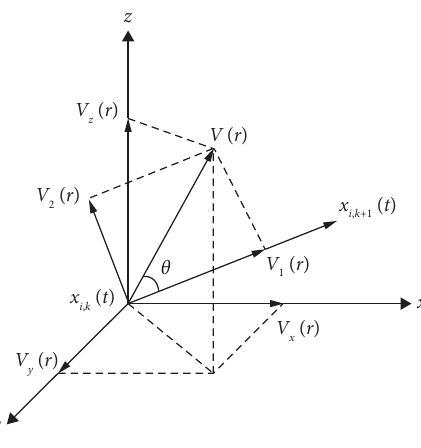
Figure 4: Vector projection of sea